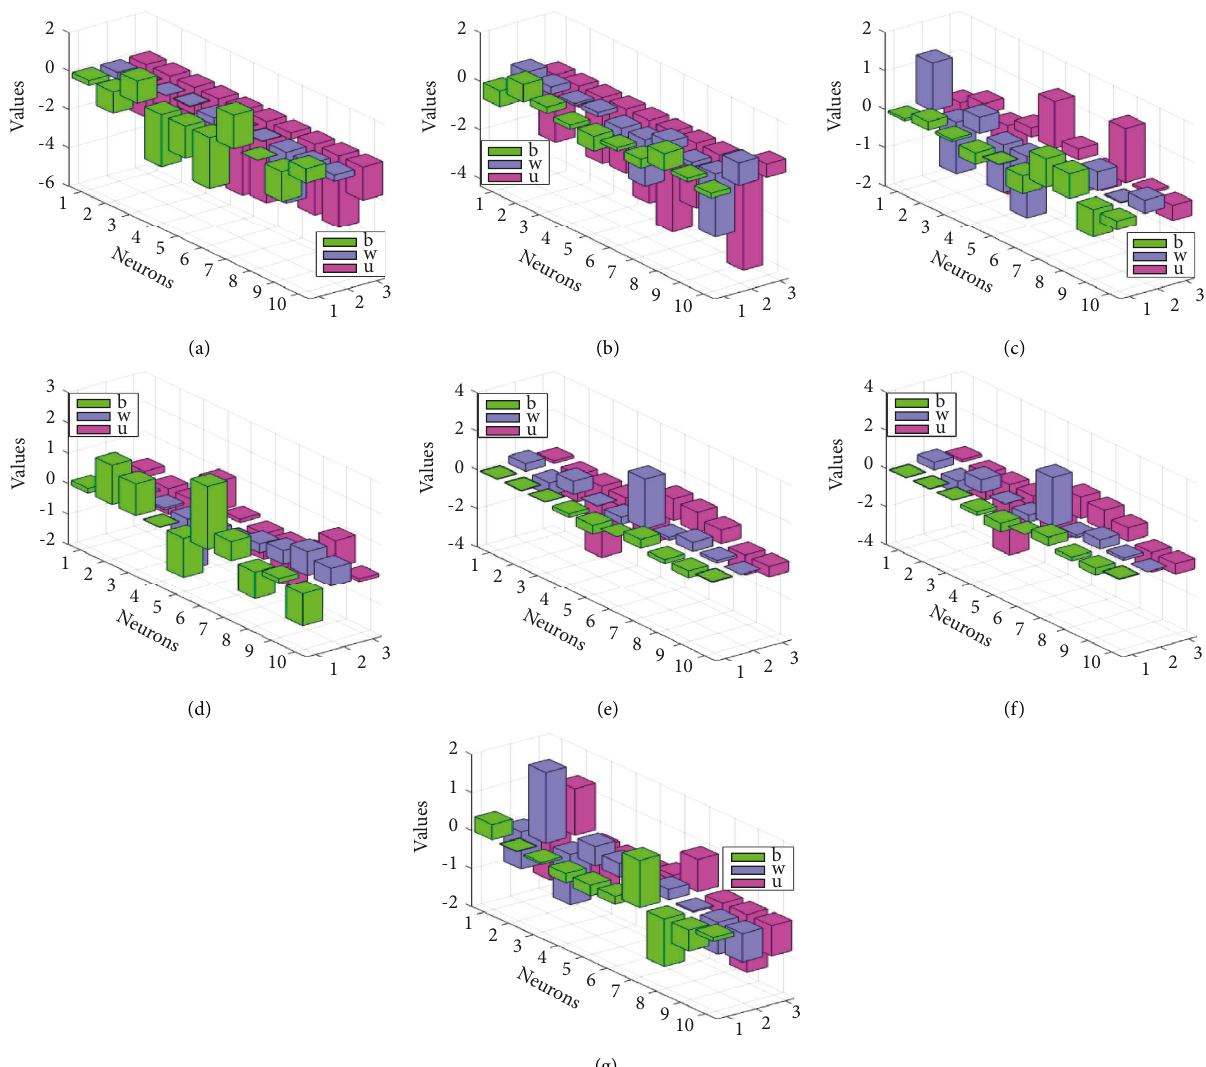
Figure 2: Weights for solving the mathematical SEIR-NDC system. (a) Weights: 􏽢 S ( y ) . (b) Weights: 􏽢 E ( y ) . (c) Weights: 􏽢 I ( y ) . (d) Weights: 􏽢 R ( y ) . (e) Weights: 􏽢 N ( y ) . (f) Weights: 􏽢 D ( y ) . (g) Weights: 􏽢 C ( y )